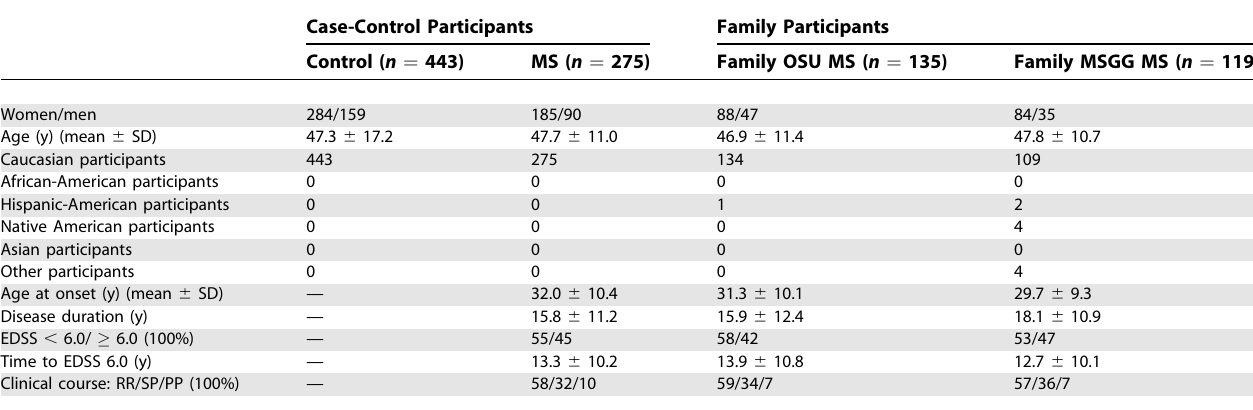
Table 1. Characteristics of MS Patients and Controls